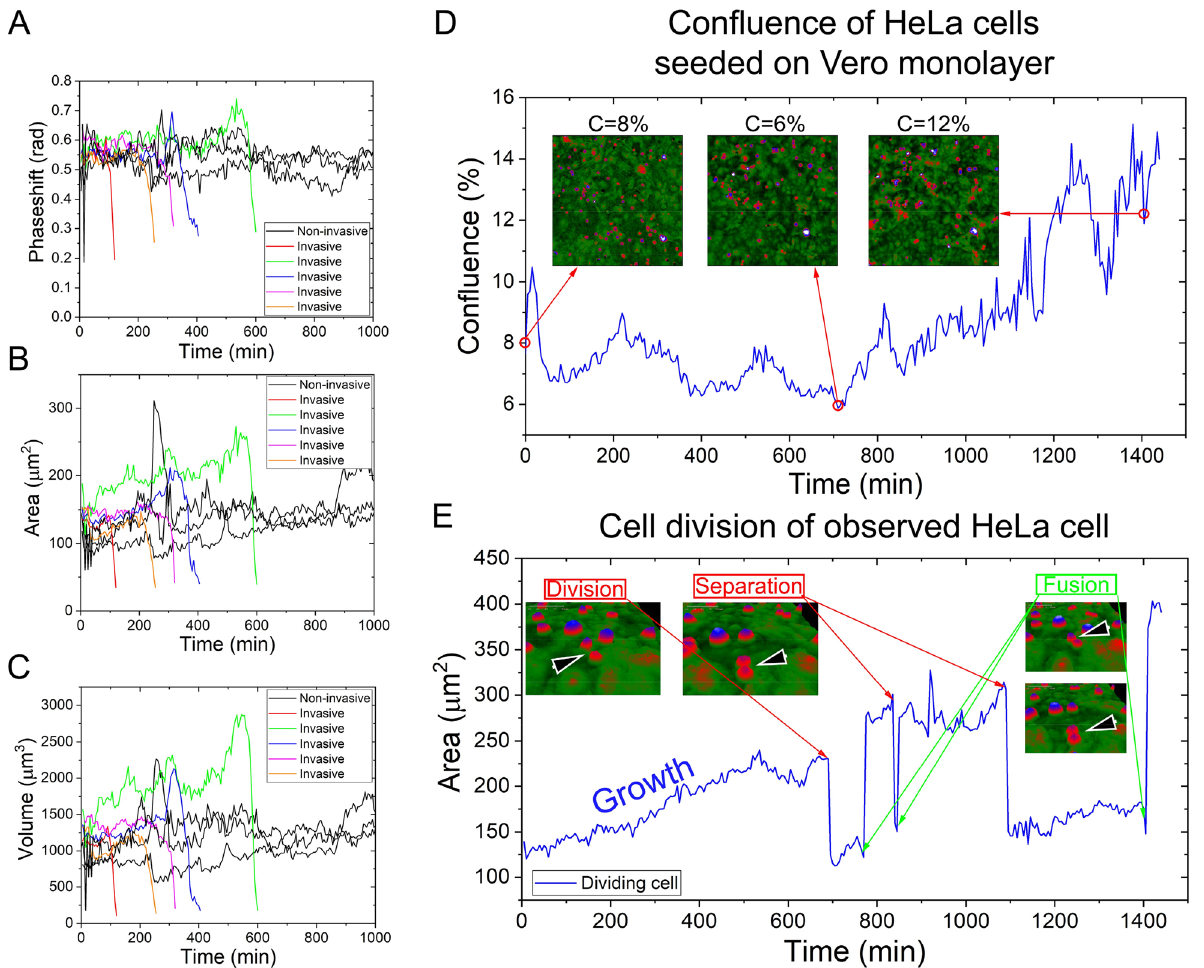
Figure 6. Results from repeated experiments show the same tendency in the phaseshift ( A ), and morphology parameters area ( B ) and volume ( C ). The HeLa cells seeded on top of the monolayer have invasive and non- invasive profiles, and the non-invasive cells divide after a certain amount of time predictable by the timespan of the cell cycle, which is visible in the confluence of the seeded HeLa cells on the monolayer over time ( D ). Non- invasive dividing HeLa cancer cells have special morphology and movement characteristics, since after division the daugther cells do not invade the epithelial Vero monolayer, but remain on top and fuse then separate multiple times observable by morphology parameters such as area ( E